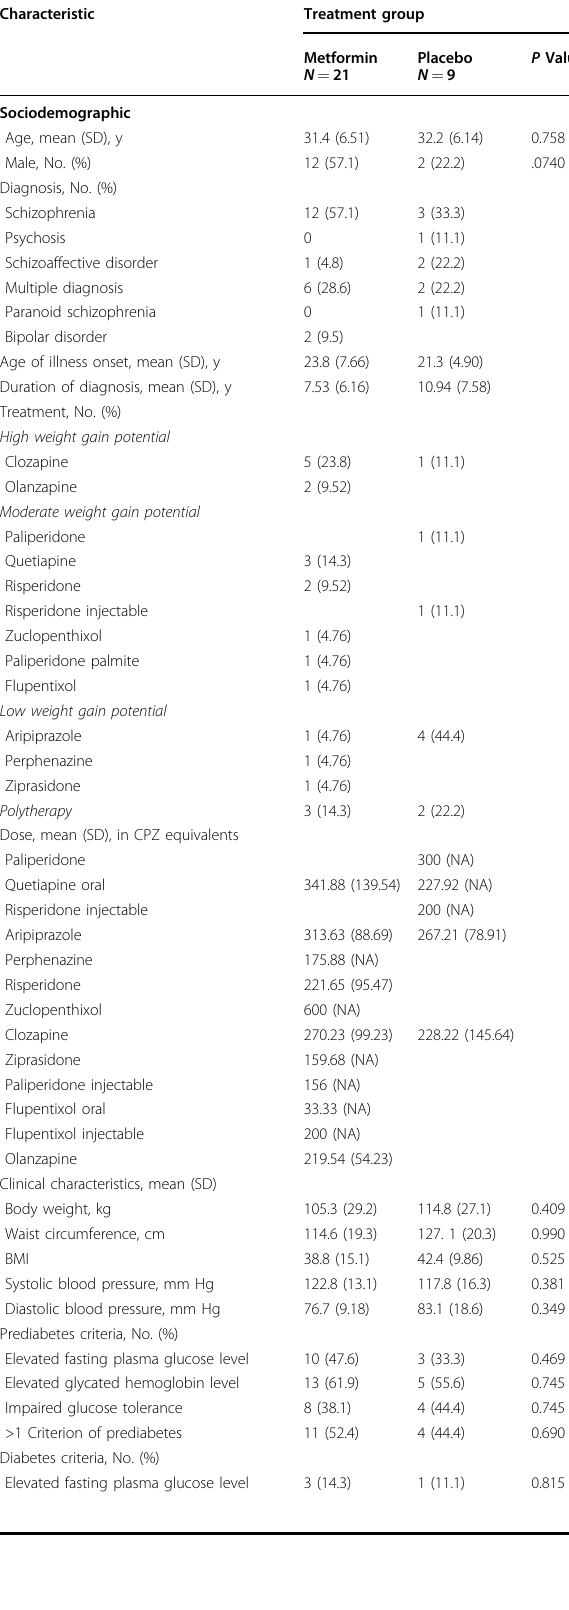
Table 1 Baseline characteristics of the study participants.